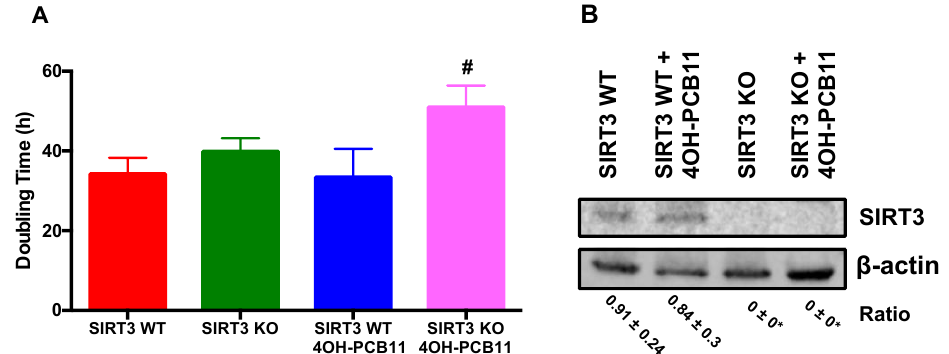
Figure 1. Treatment with 3 μM 4OH-PCB11 for 24 h decreased the cell growth in SIRT3-KO MEFs. ( A ) Doubling times of WT and SIRT3-KO MEFs treated with Vehicle (0.1% v/v DMSO) or 3 μM 4OH-PCB11 for 24 h. Data are mean doubling times of cells from six treatment dishes from two separate experiments performed in triplicate ( ± 1SD), n = 6. # p < 0.05, as compared to the vehicle-treated SIRT3-KO group. ( B ) Western blot analysis of Sirt3 immunoreactive protein in WT and SIRT3-KO MEFs following 24 h treatment with 3 μM 4OH-PCB11 or vehicle. β-actin was used as a loading control. The quantitation was presented as the average + 1SD ratio of SIRT3 to β-actin in fluorescence units from three different blots * p < 0.05 as compared to vehicle-treated SIRT3-WT group.